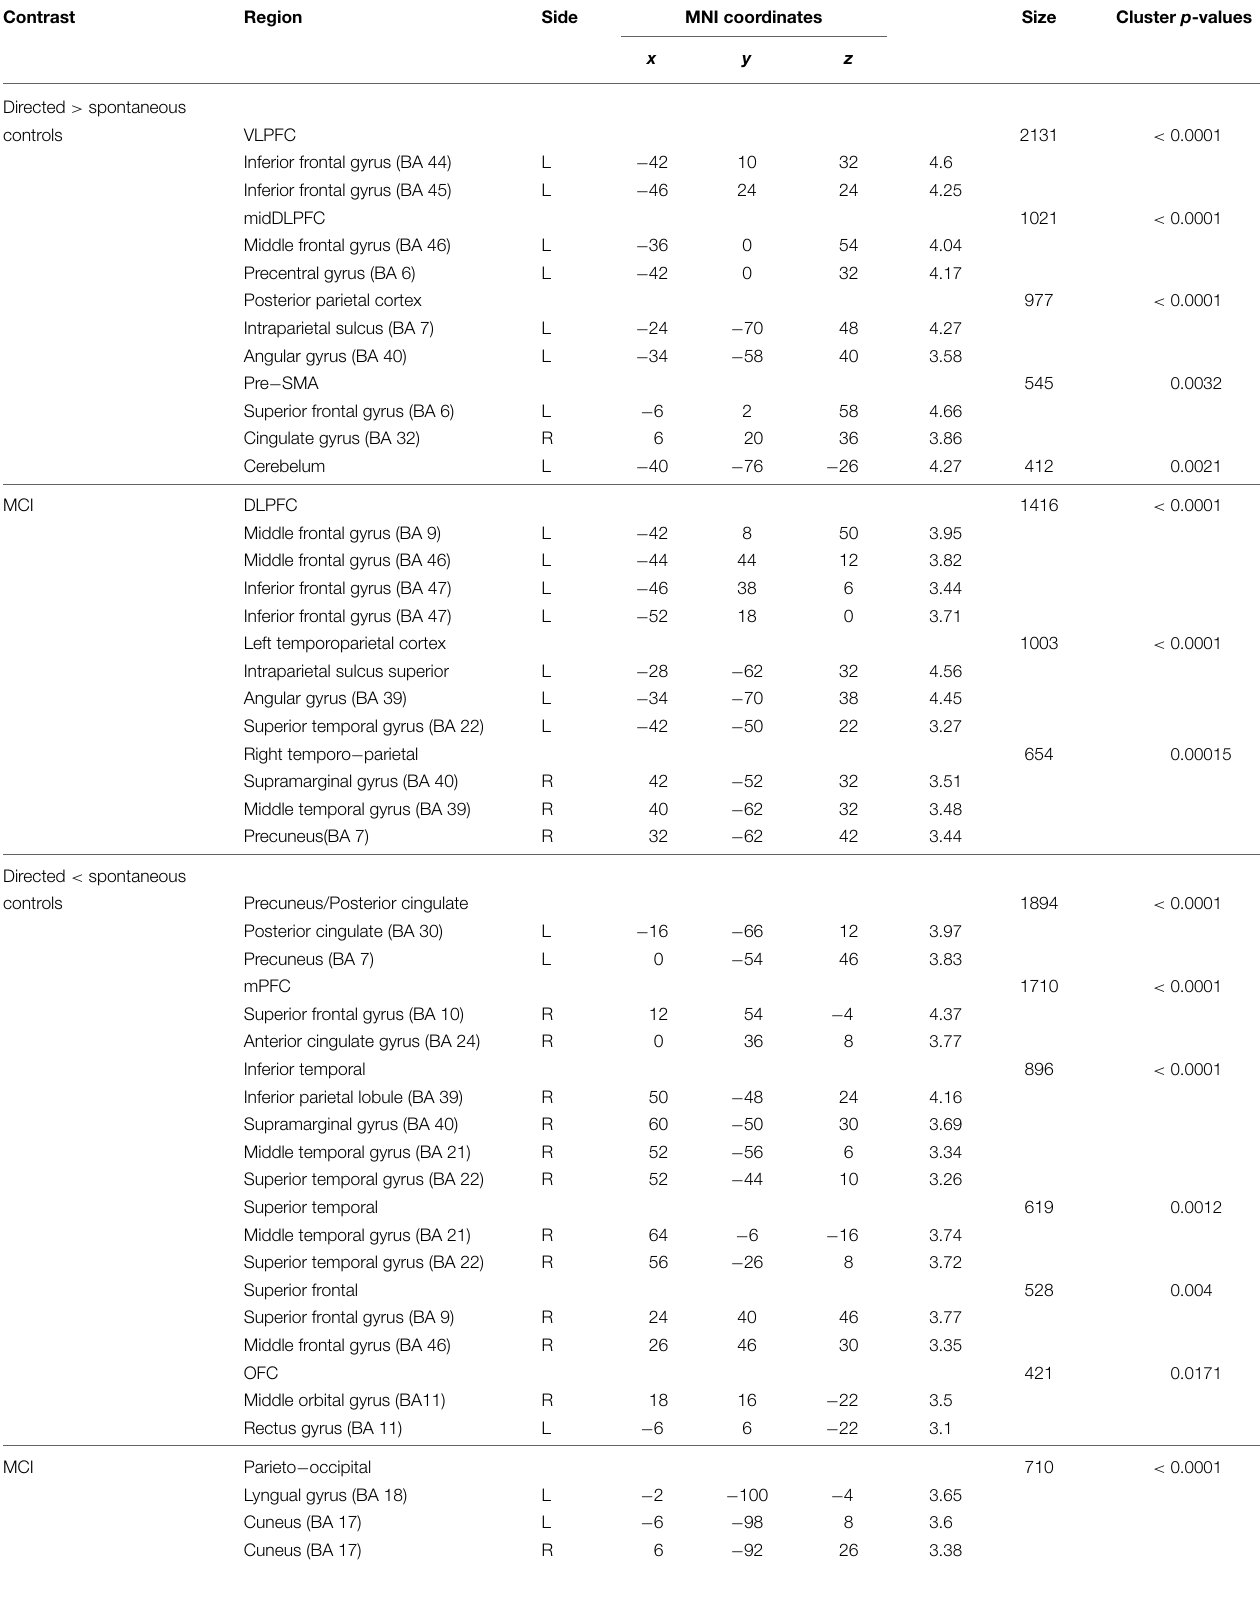
TABLE 3 | Statistical information of significant clusters highlighted when comparing the BOLD response between the spontaneous and directed use of learning strategies during word list encoding compared to fixation baseline. Contrast Region Side MNI coordinates Size Cluster p -values x y z Directed > spontaneous